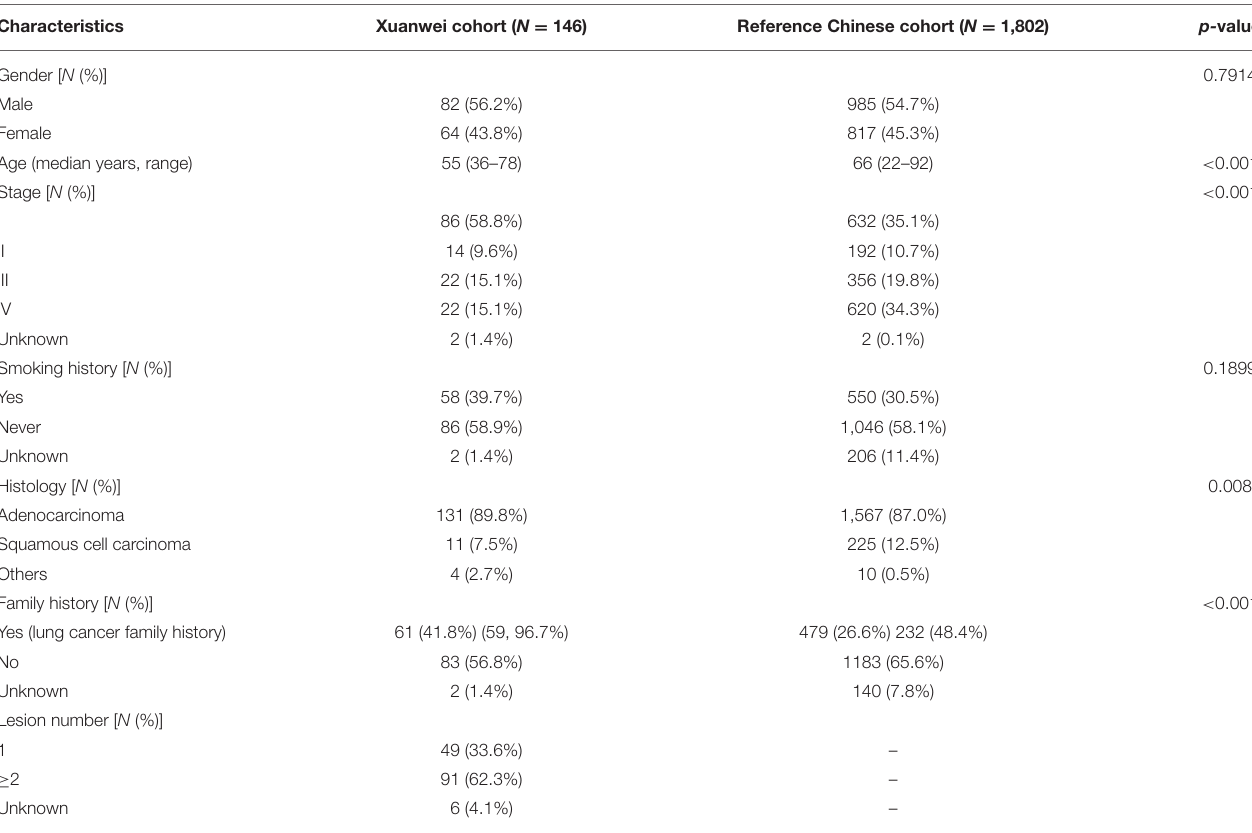
TABLE 1 | Clinicopathological baseline characteristics of patients from Xuanwei and reference Chinese patients with NSCLC.